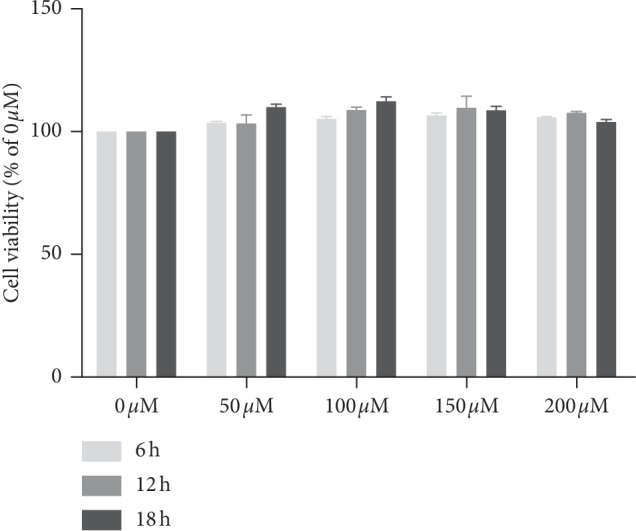
Ginsenoside Rb1 (GS- Rb1) is not cytotoxic to H9c2 cells at concentrations of up to 200 μM and incubation times up to 18 h. GS-Rb1 appeared to enhance the viability of H9c2 cells, and this effect became more obvious with the prolongation of treatment time. Cell viability in the absence of GS-Rb1 (0 μM) was set at 100%.